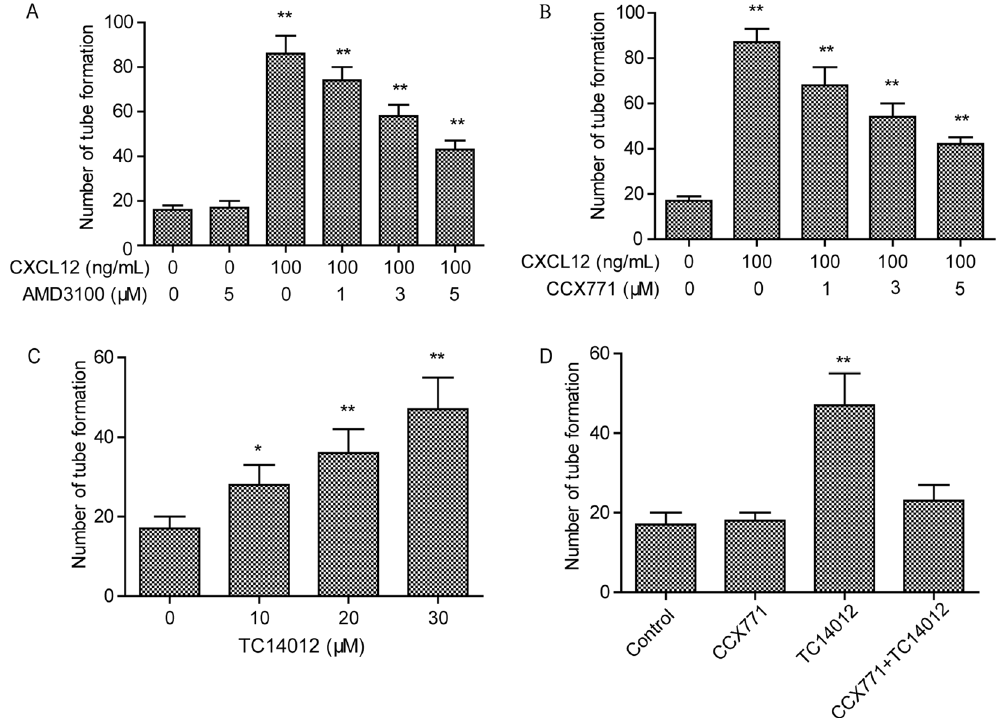
Figure 3. CXCL12 mediates tube formation through both CXCR4 and CXCR7 in HUVECs. ( A ) CXCR4 inhibitor AMD3100 (0–5 μ M) does not completely block the tube formation mediates by CXCL12 in HUVECs. * p < 0.05/ ** p < 0.01 versus CXCL12. ( B ) CXCR7 inhibitor CCX771 (0–5 μ M) does not completely block the tube formation mediates by CXCL12 in HUVECs. * p < 0.05/ ** p < 0.01 versus CXCL12. ( C ) CXCR7 special agonists TC14012 (0–30 μ M) enhanced the tube formation in HUVECs. ( D ) CXCR7 inhibitor CCX771 (5 μ